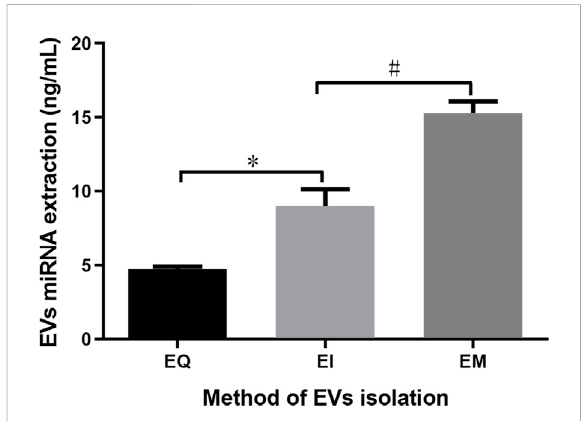
FIGURE 2 Comparison of total EVs ’ miRNAs from the EQ, EI, and EM groups.8 mlofthecellculturemediumsupernatantwascollected from HepG2 (1.01×10 7 cells per dish), and 13.3 ml supernatant was individually applied for EVs ’ miRNAs isolation by each kit. Duplicate samples were analyzed for each group. The total